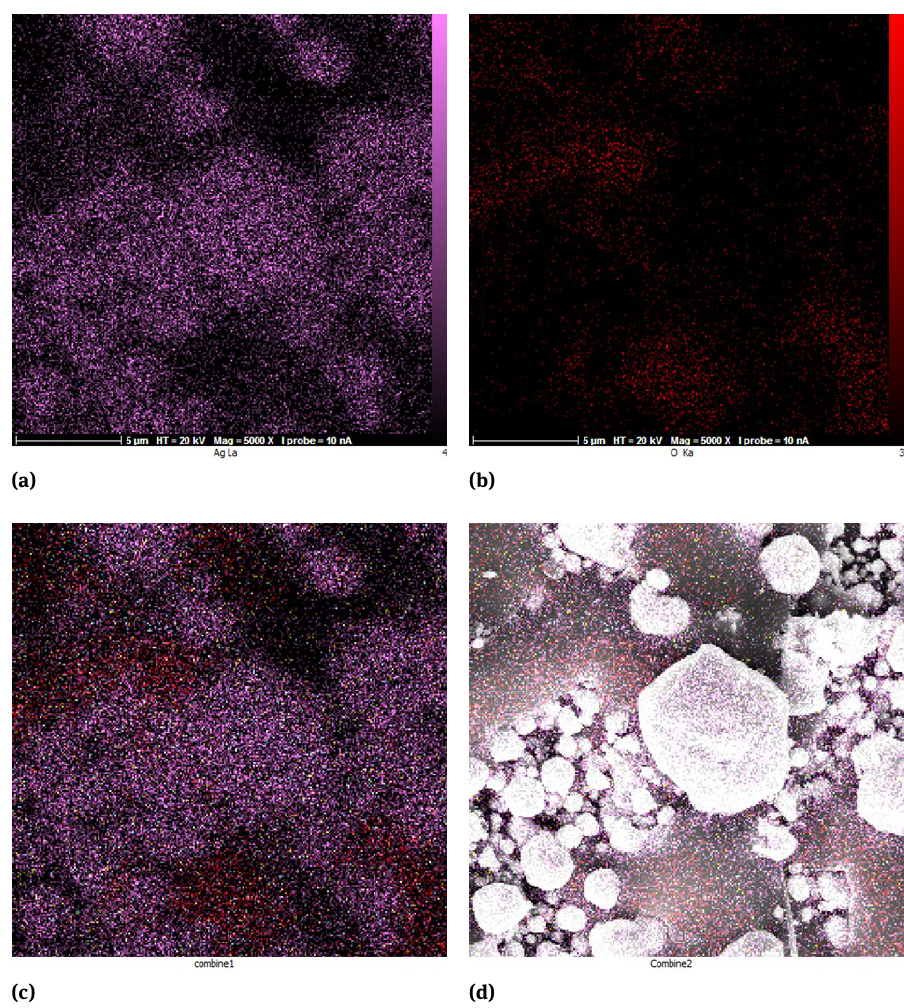
Figure 4: FE-SEM dot maps of Ag 2 O NPs surface morphology corresponding to; (a) AgNPs distribution, (b) oxygen distribution, (c) combine of silver and oxygen elements distribution, and (d) silver and oxygen elements distribution combine with FE-SEM image.